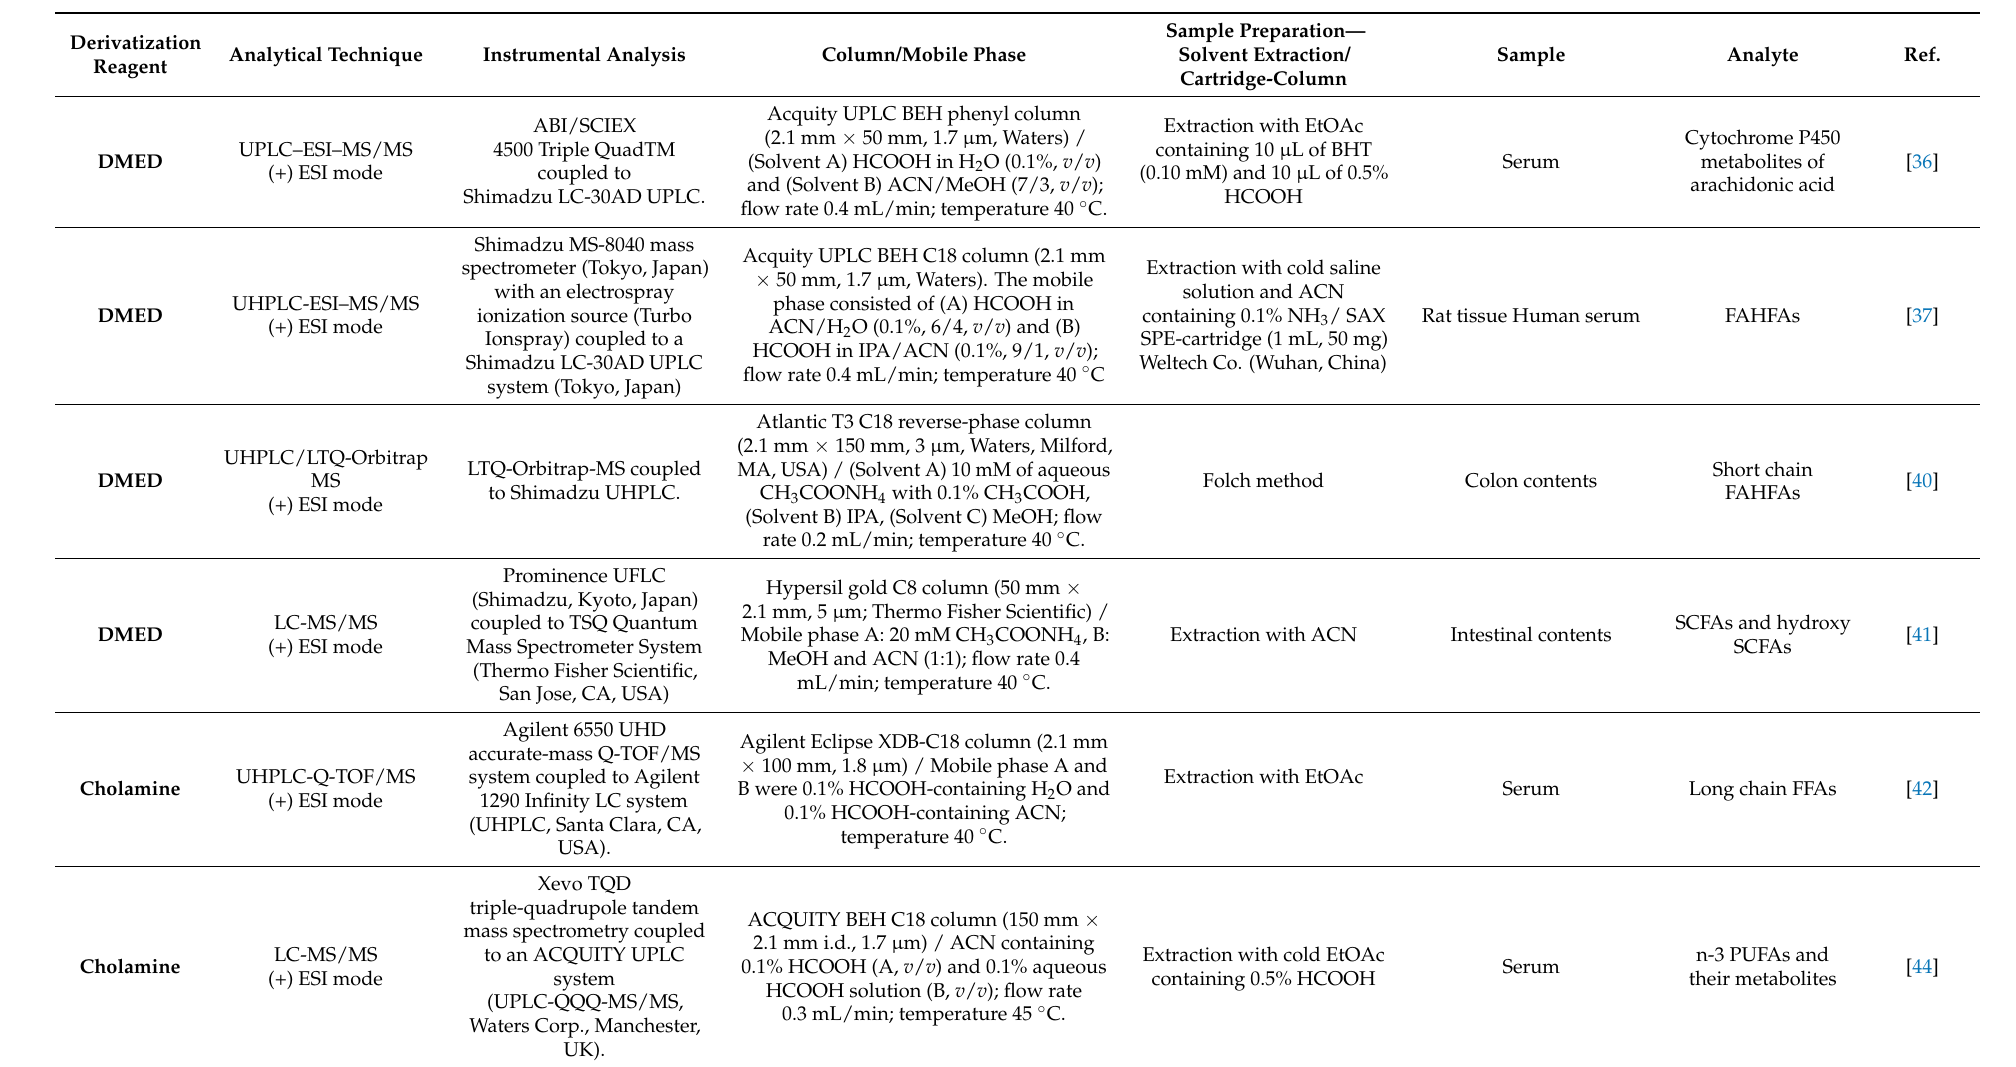
Table 1. Summary of FA carboxyl group derivatization reagents and their applications using